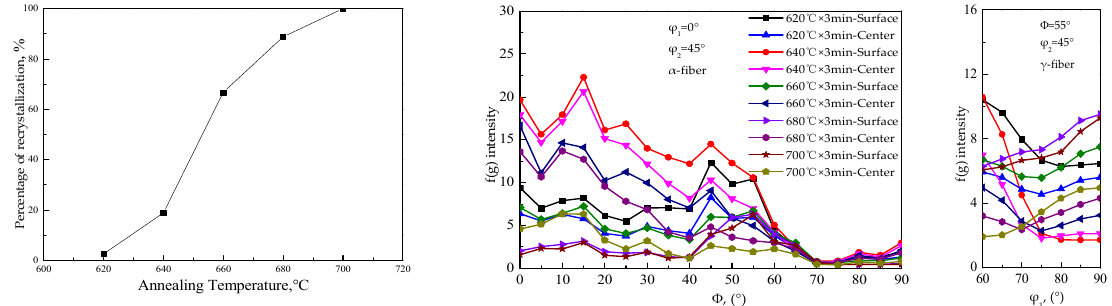
Figure 5. Relationship between recrystallization percentage and annealing temperature, orientation line distribution of α and γ fiber textures in Fe-0.65%Si non-oriented electrical steel during recrys- tallization.